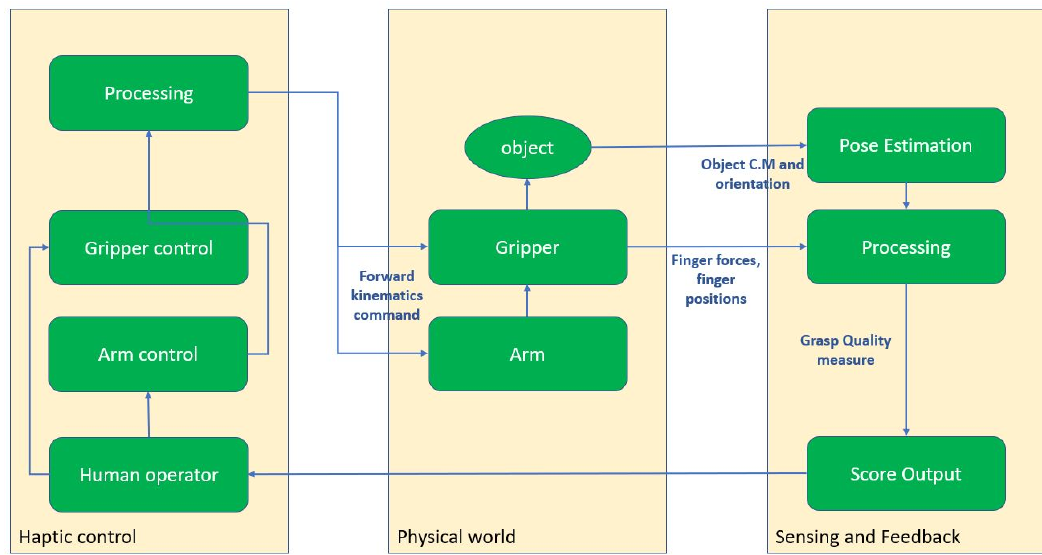
Figure 2. Interaction between the different components in the experimental